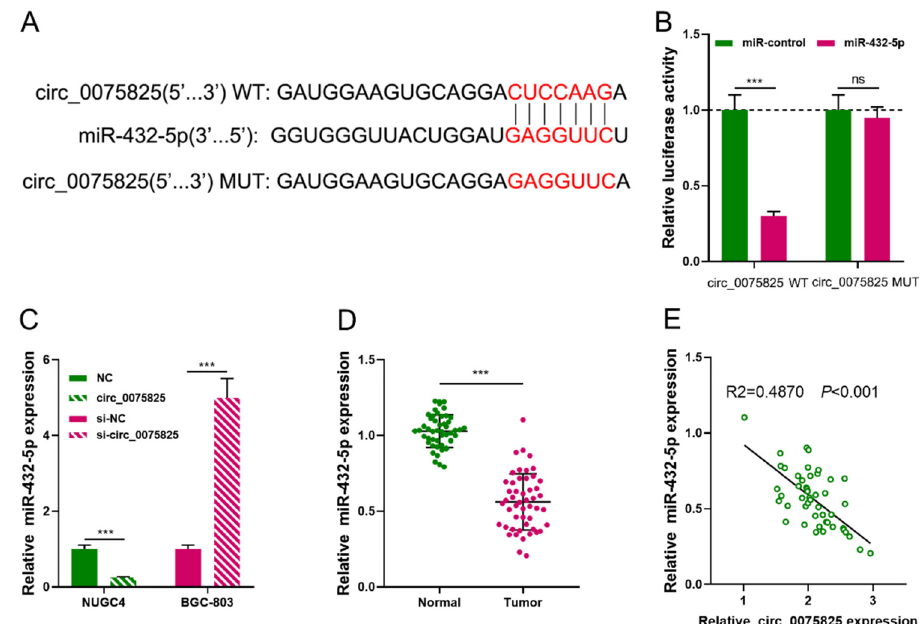
Fig. 3. Circ_0075825 directly interacts with miR-432-5p. (A) Circinteractome online bioinformatics tool was used to predict the binding site between circ_0075825 and miR-432-5p. (B) Dual-luciferase reporter assay showed that circ_0075825 adsorbed miR-432-5p. (C) qRT-PCR assay was used to detect the expression of miR-432- 5p in GC cells after transfection with circ_0075825 or si-circ_0075825. (D) The expression of miR-432-5p in GC tissues ( n =50) and adjacent tissues ( n =50) was detected by qRT-PCR assay. (E) ' 'Spearman's correlation analysis was used to analyzing the correlation between circ_0075825 expression and miR-432-5p expression